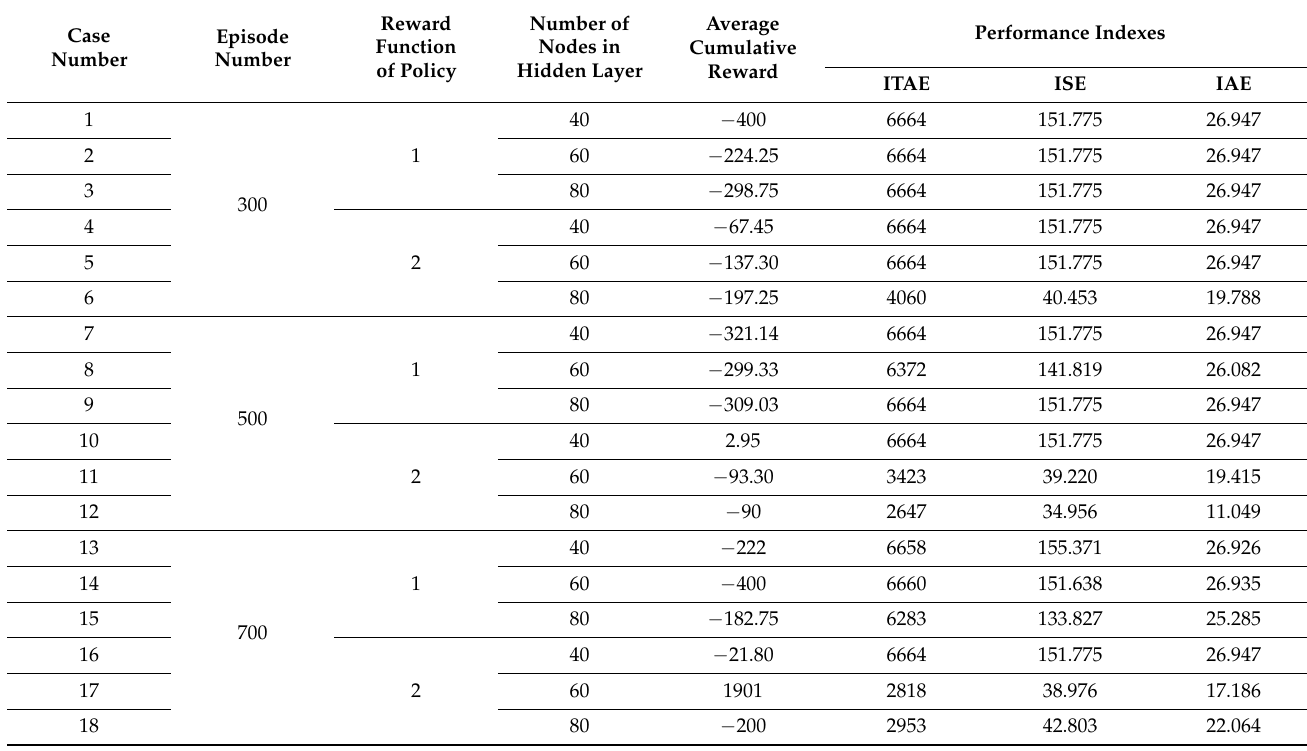
Table 4. Grid search results of pH